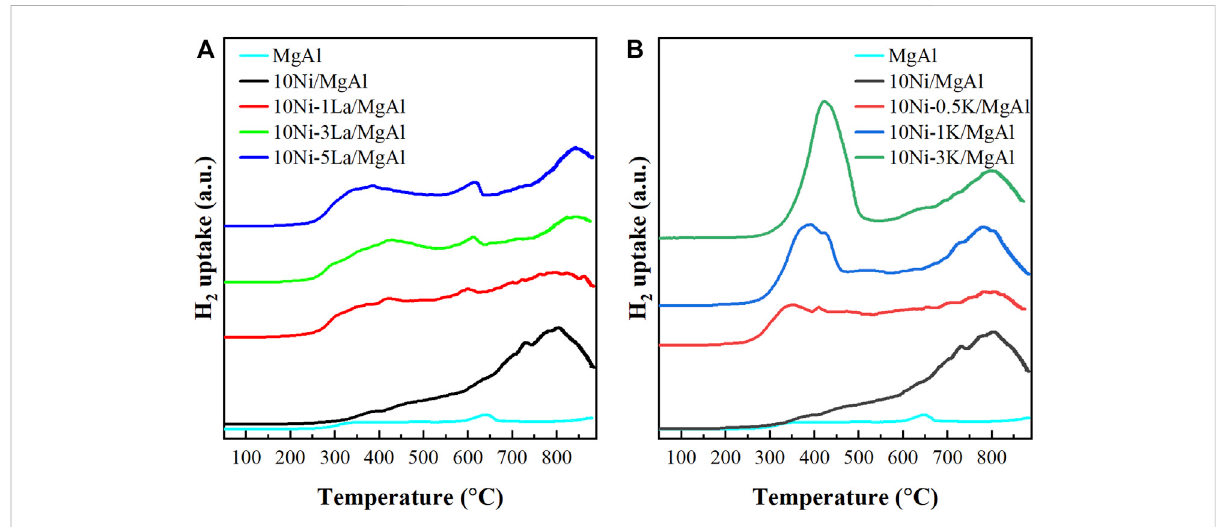
FIGURE 5 H 2 -TPR pro fi les of the MgAl supporting material, 10Ni/MgAl catalyst, the La-promoted catalysts (A) and the K-modi fi ed catalysts (B) .